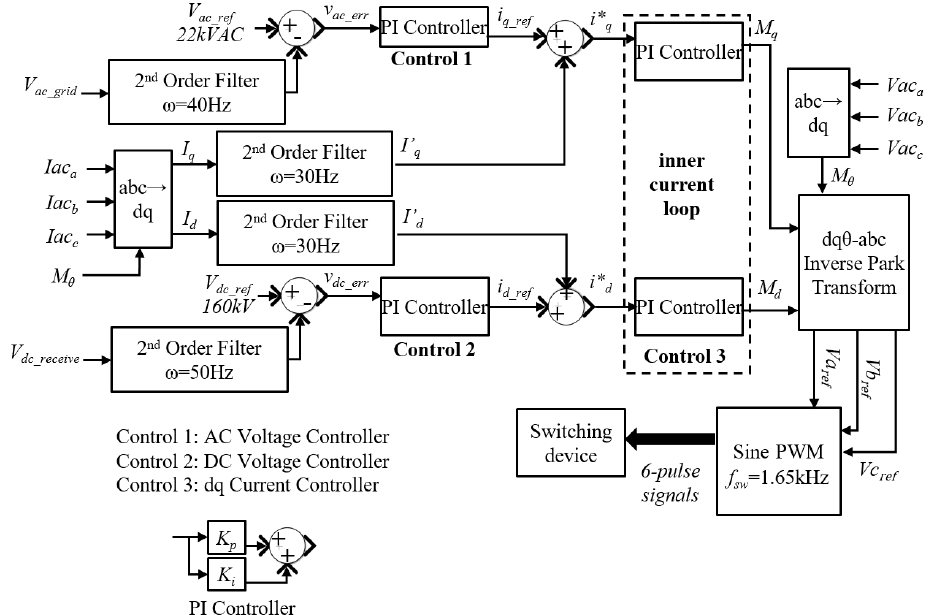
Figure 7. Control architecture for Grid-side